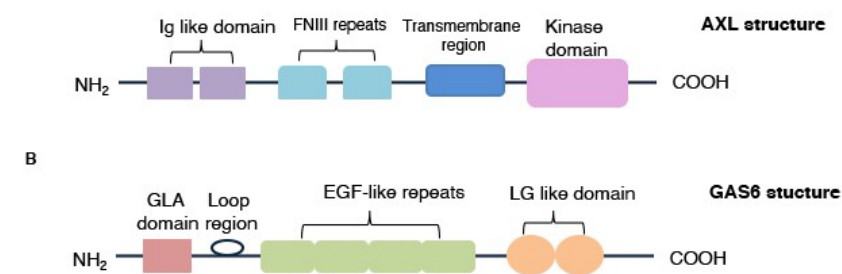
Figure 1. AXL receptor and GAS6 protein structures. ( A ) AXL is structurally composed by two immunoglobulin (Ig)-like domains, two fibronectin type III (FNIII) repeats, a transmembrane